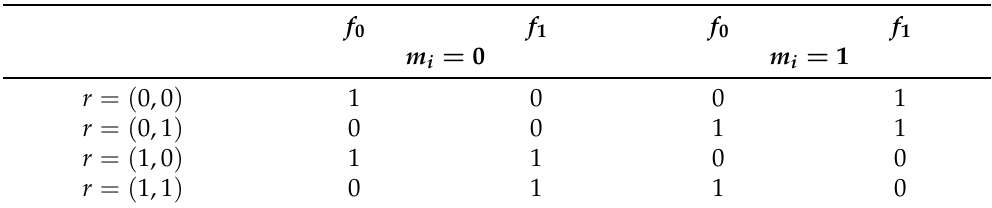
Table 1. The values of the M block for the position of the robot in the map. m 0 = 0 and m 0 = 1 are associated, respectively, with a counter-clockwise and clockwise movement so that for example, if the robot is in ( 0,0 ) and m 0 = 0, the new position is ( 1,0 ) . f 0